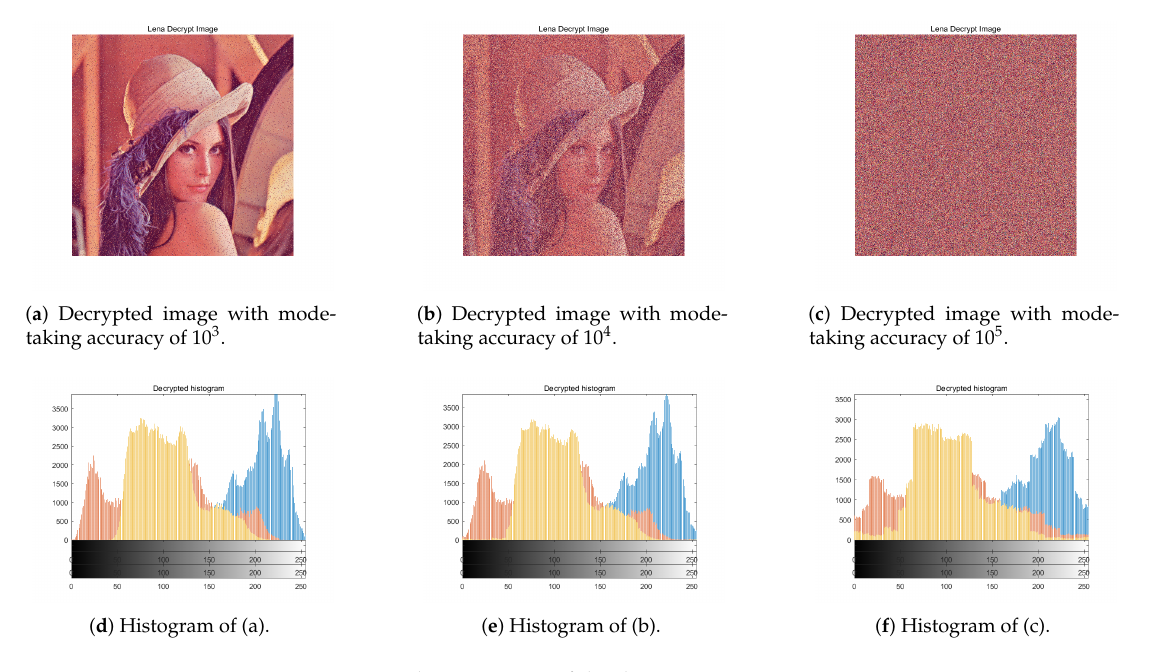
Figure 5. The sensitivity of the decryption sequences.